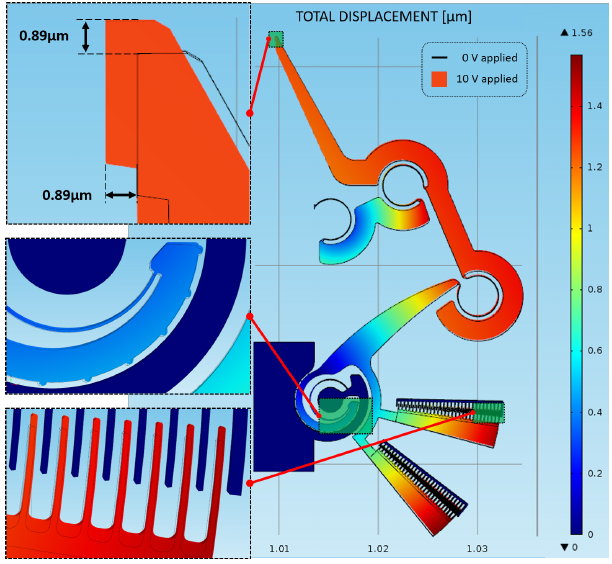
Figure 6. Simulated structure’s total displacement: 0V configuration (wireframed) and 10V configuration (colored) with three enlargements on the jaw-tip (top left), conjugate surfaces (center left) and comb drive fingers (bottom